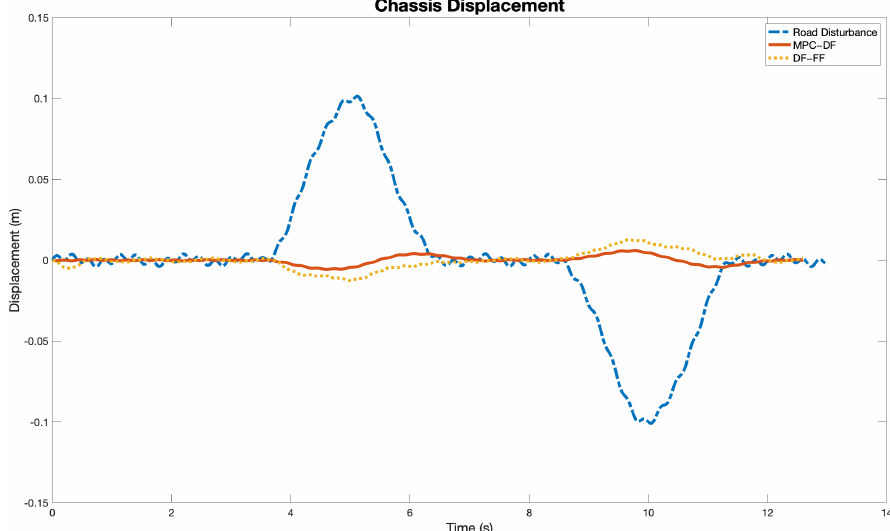
Figure 4. Chassis Displacement (Blue–Road Disturbance, Red–MPC-DF, Yellow–DF-FF).